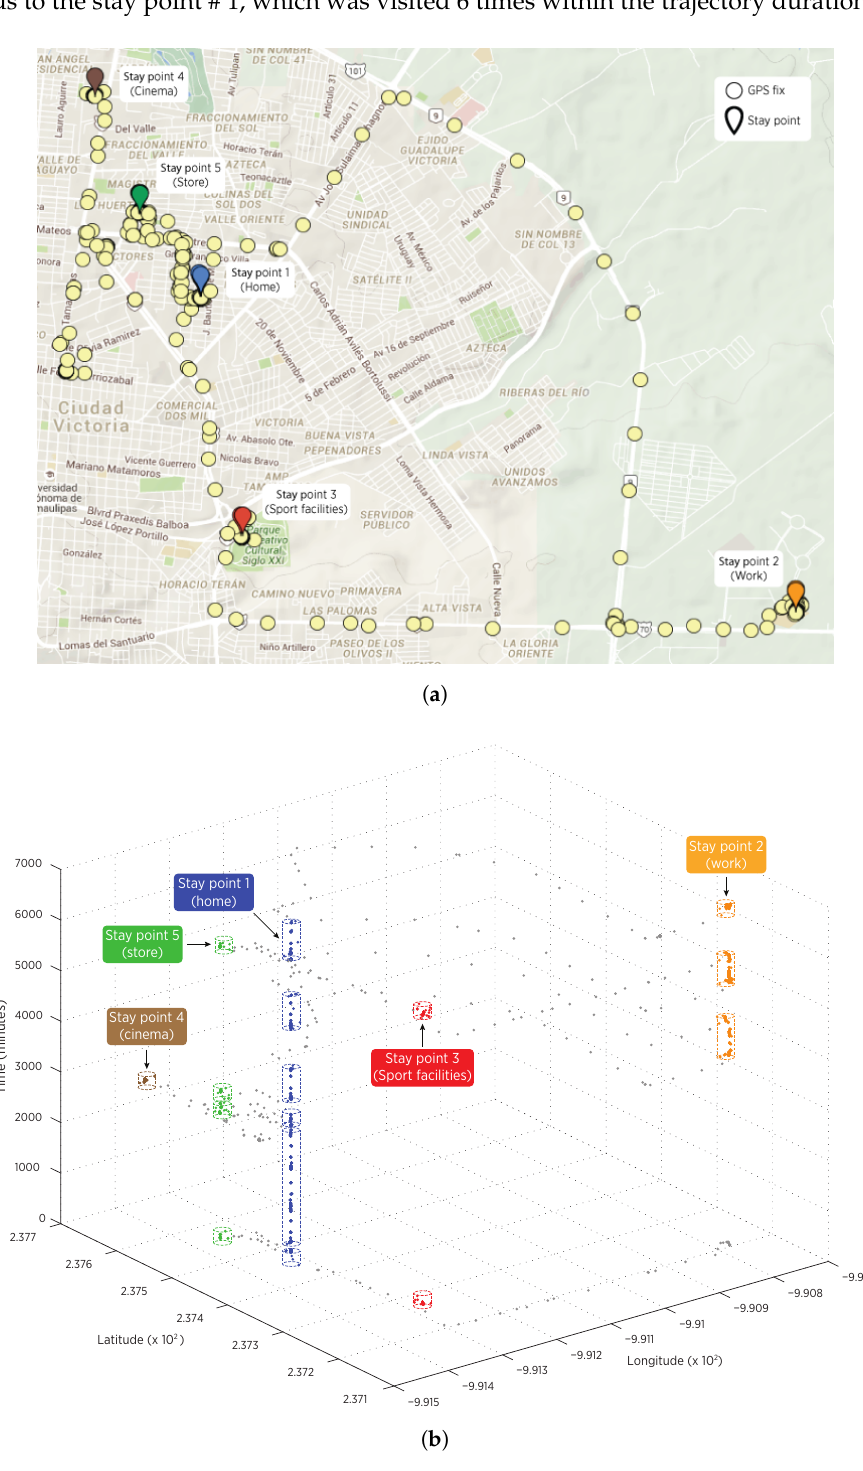
Figure 5. Location fixes and stay points rendered as pins in maps. The temporal aspect is discarded. ( a ) Location fixes and stay points rendered as grouped cylindrical regions in a three-dimensional coordinate system composed by longitude, latitude and time; ( b ) Visualization of a set of stay points found in the